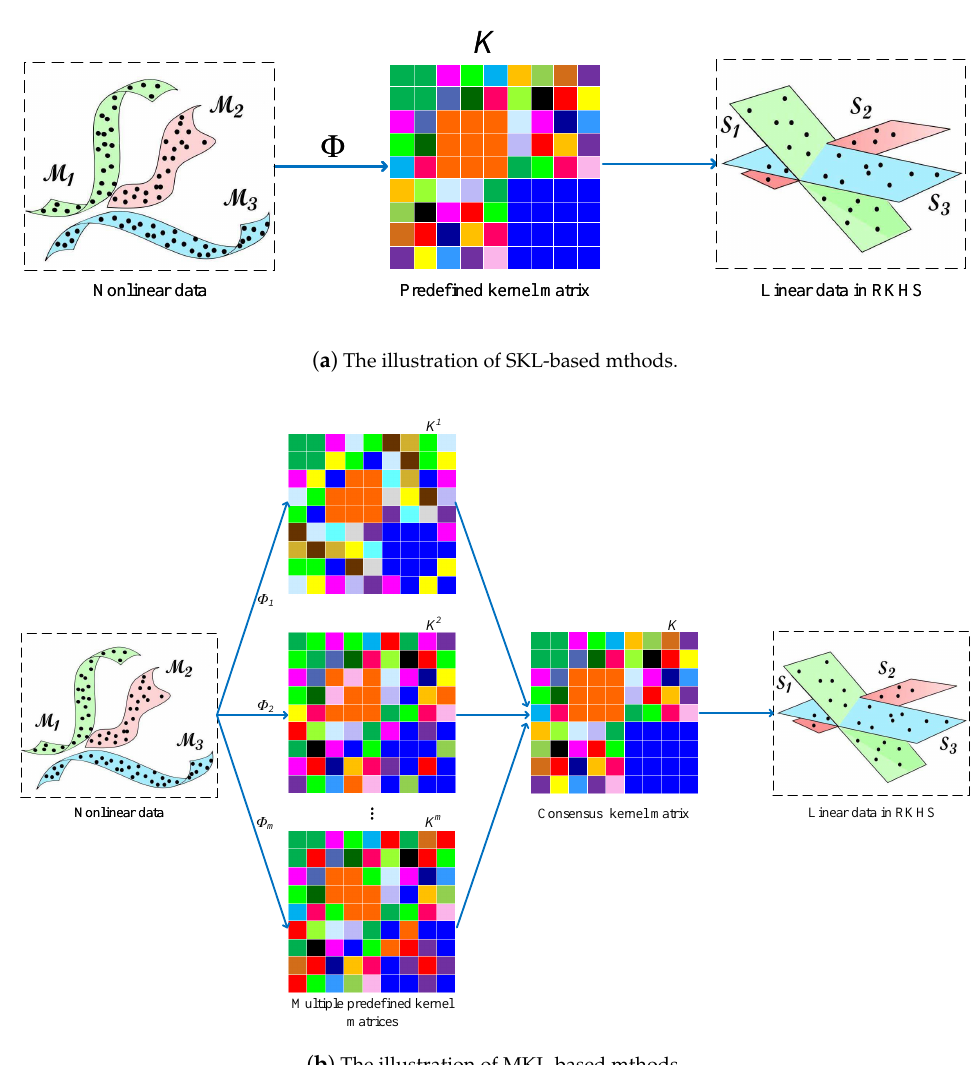
Figure 8. The illustration of SKL-based methods and MKL-based